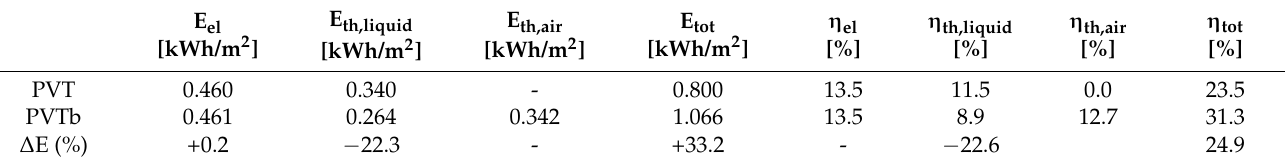
Table 3. Energy yields of the conventional (PV/T) and bi-fluid-collector (PVTb).